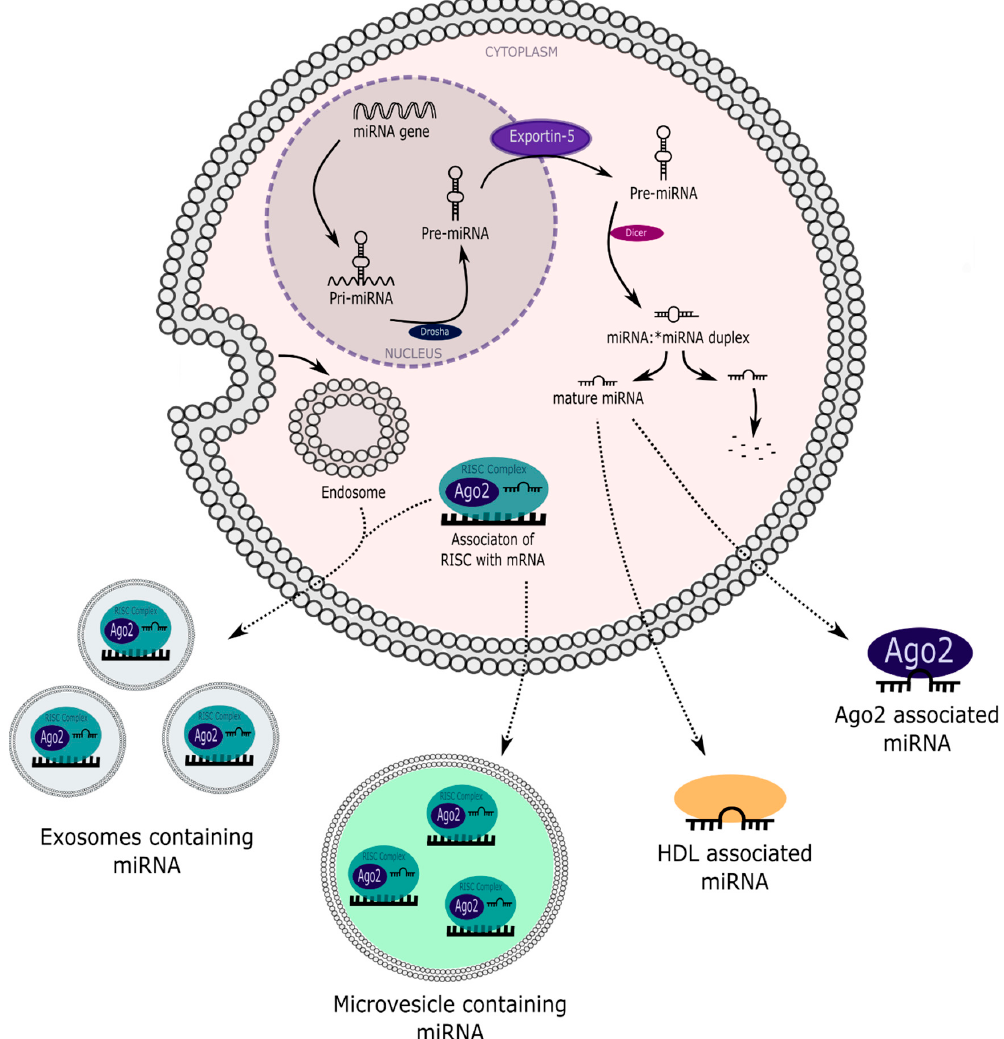
Figure 3. miRNA release mechanisms. HDLs, high-density lipoproteins; pre-miRNAs, precursor miRNAs; pri-miRNAs, primary miRNAs.